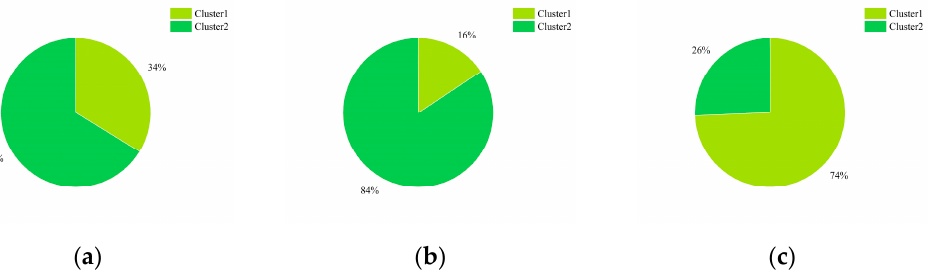
Figure 11. The accounted percentage of different heating patterns in Shanxi’s living rooms (( a ). Early heating period; ( b ). mid heating period; ( c ). late heating period).